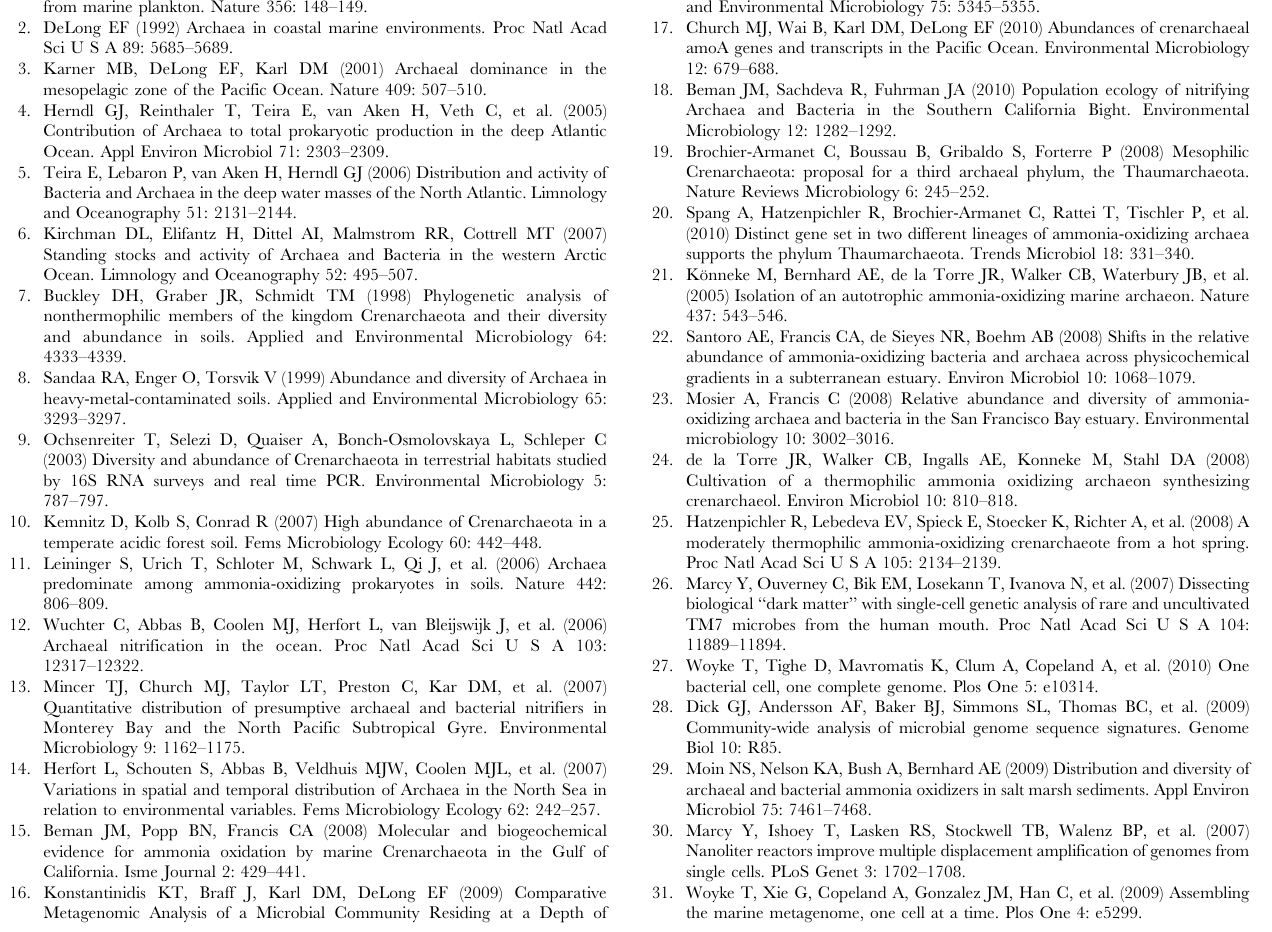
Figure S2 GC content of raw 454 reads from the 5 single cells and the AOA enrichment. The GC content of the filtered set of reads used for the final assembly of N. limnia and simulated reads from the N. maritimus genome are also shown.